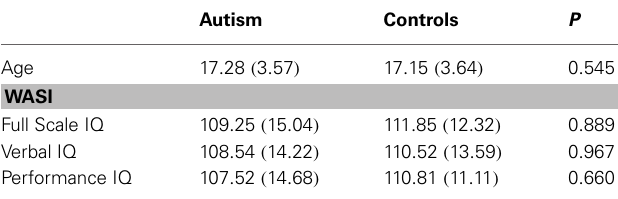
Table 1 | Mean age and IQ scores.